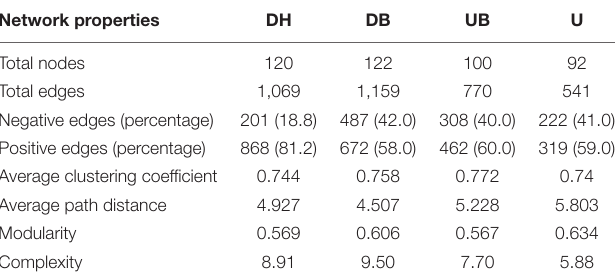
TABLE 3 | Network topological properties between different disturbance biocrusts. Network